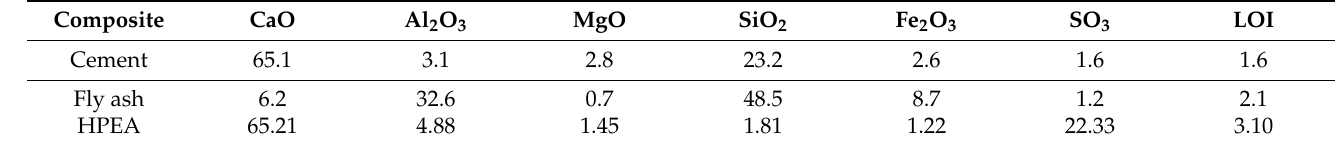
Table 1. Chemical composition of materials used. (Mass fraction,